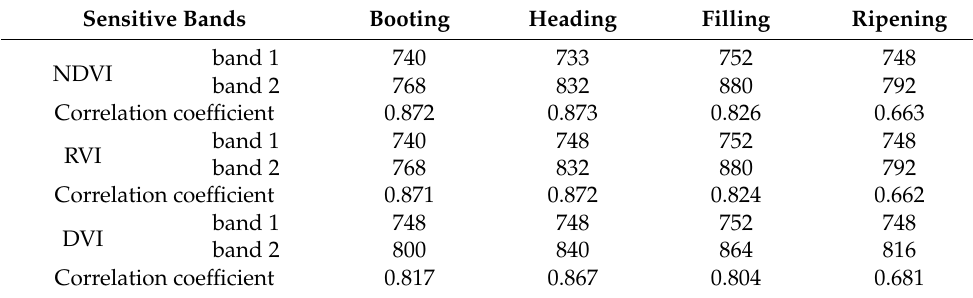
Table 3. Band locations of vegetation indices best suitable for yield